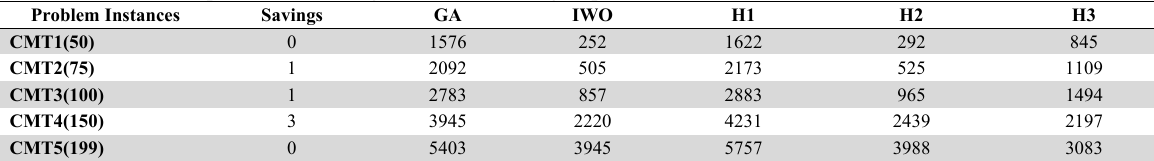
CPU time (msec) comparisons of the algorithms for CMT group test